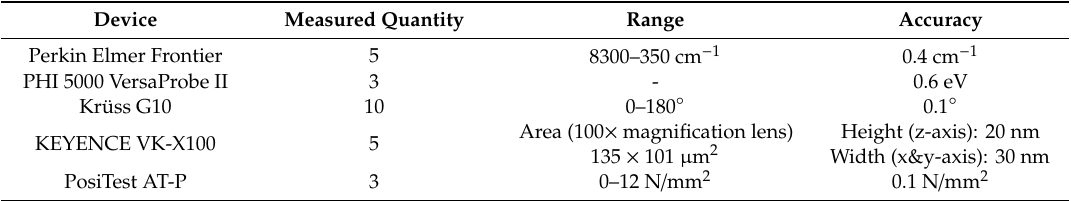
Table A1. Equipment list of analytical devices used for the presented study with range and